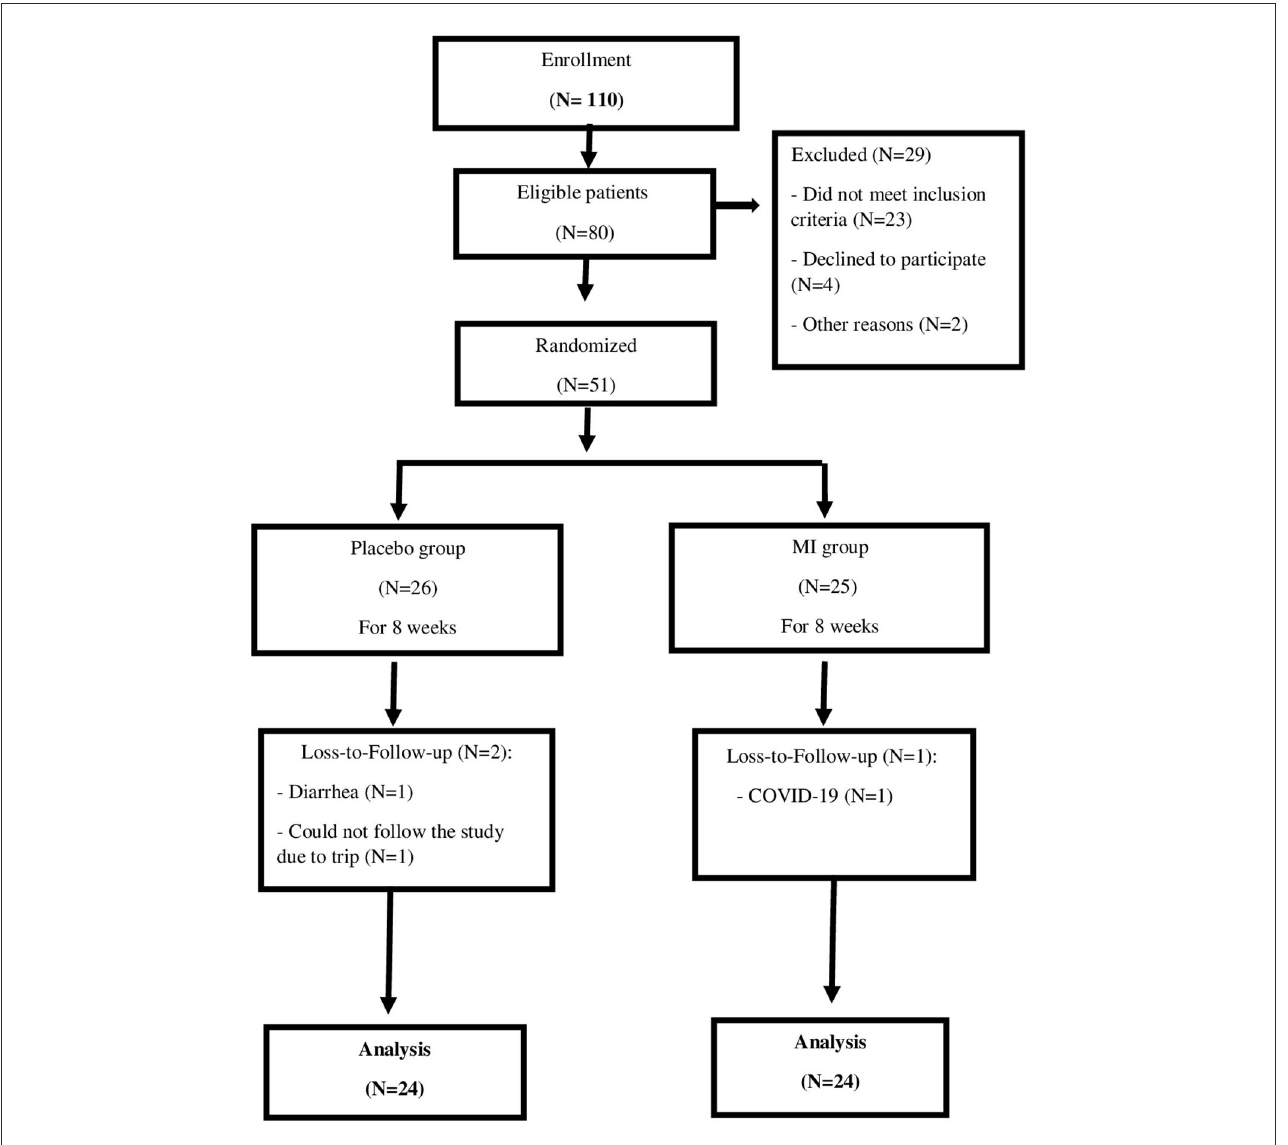
FIGURE1 Study flow